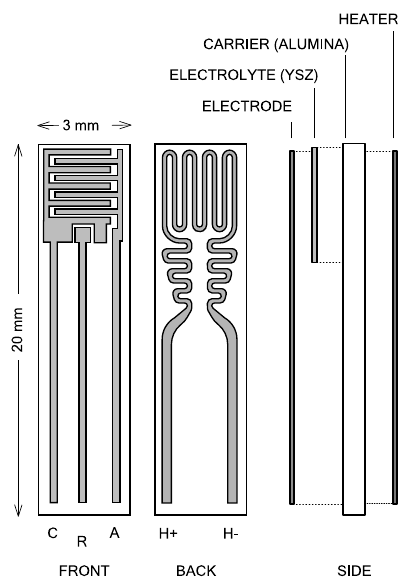
Figure 1. Layout of a FIPEX sensor. Electrodes are made of plat- inum; for atomic oxygen sensors the cathode is additionally gold coated.